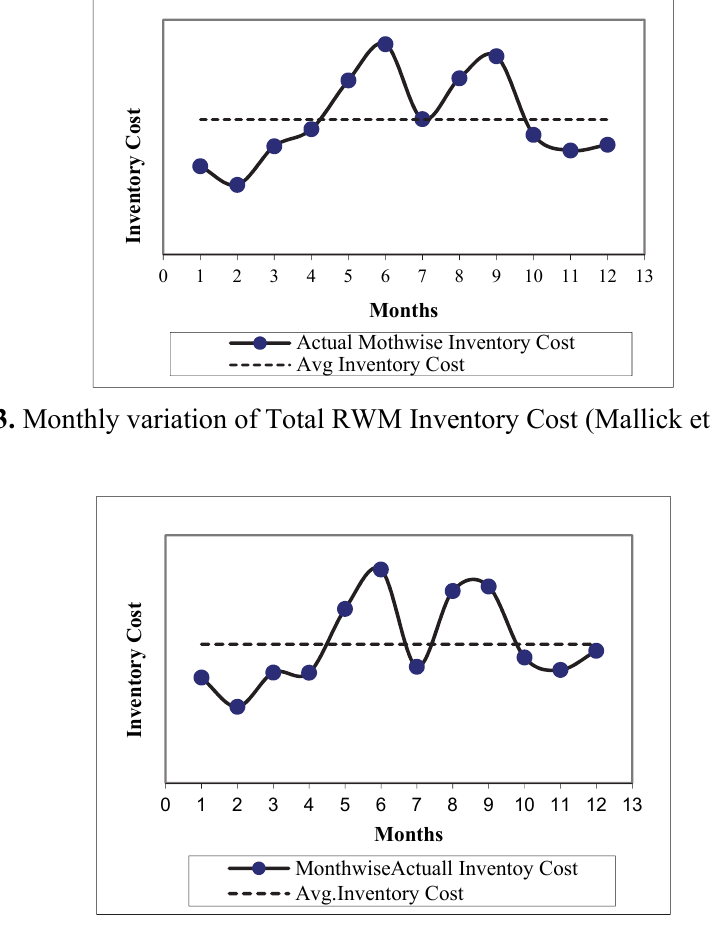
Fig. 4. Monthly variation of Total Inventory Cost for 4 categories stated for the paper (Mallick et al.,